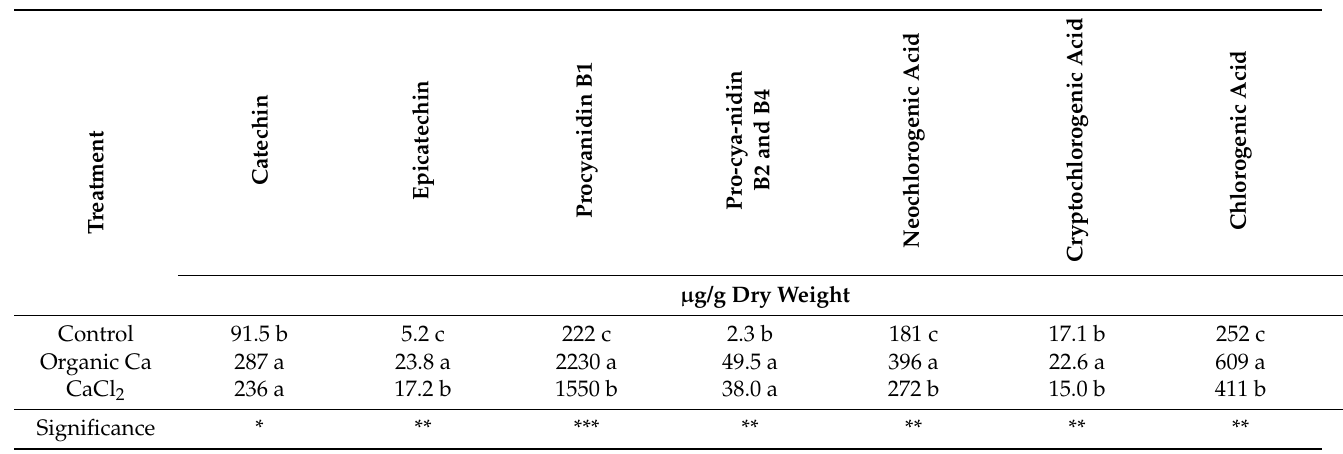
Table 5. The effect of the calcium formulation application on the major individual phenolic com- pounds at the Kato Lehonia orchard in 2020.